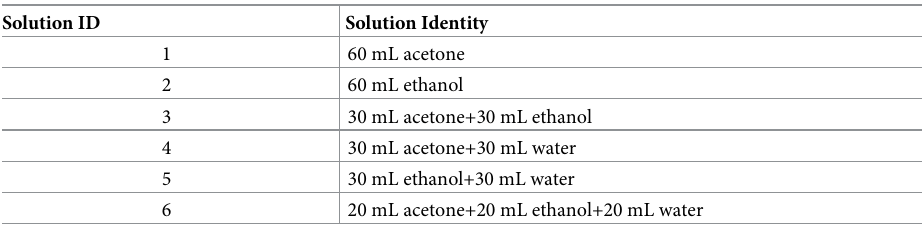
Table 1. Volatile mixtures